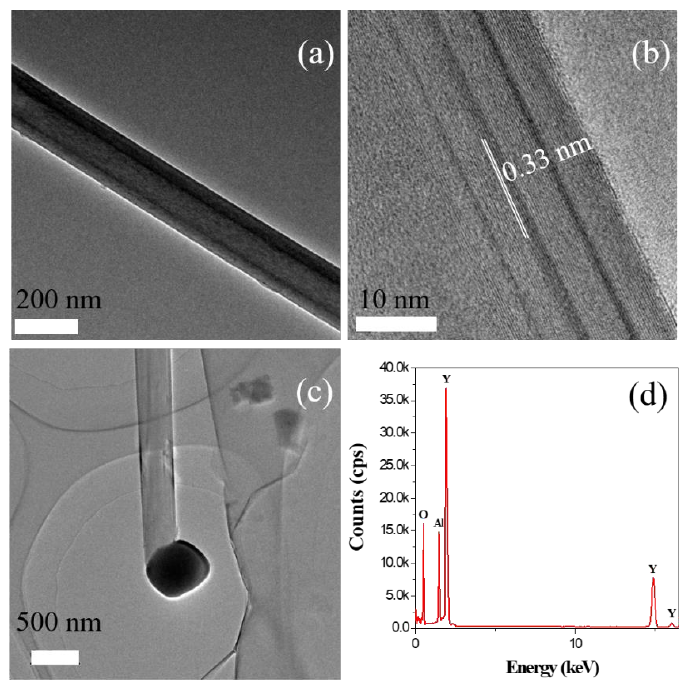
Figure 3. TEM microstructures of ( a ) the BN nanotube, ( b ) the tube wall, ( c ) nanotubes of the end tip, and ( d ) the EDS pattern of the spherical end tip.